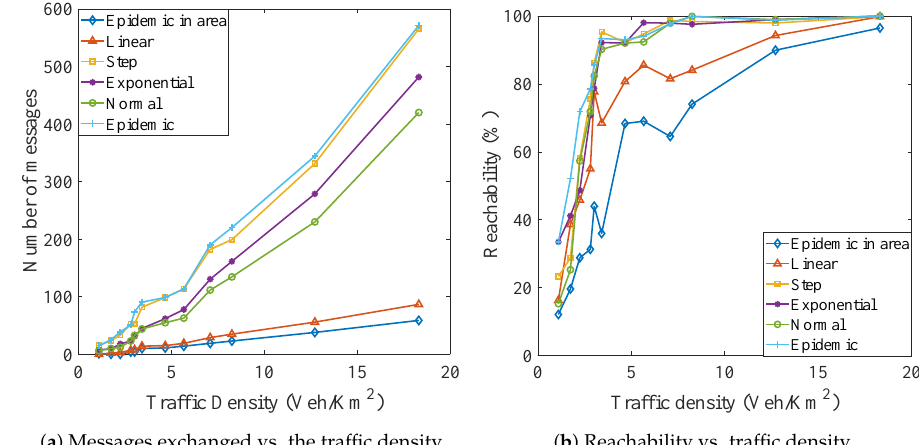
Figure 4. Number of messages exchanged and the Reachability vs. the traffic density for each of the candidate probability functions; epidemic routing inside the area (dark blue), linear (red), step (yellow), exponential (purple), normal (green), and epidemic routing in the entire network (light